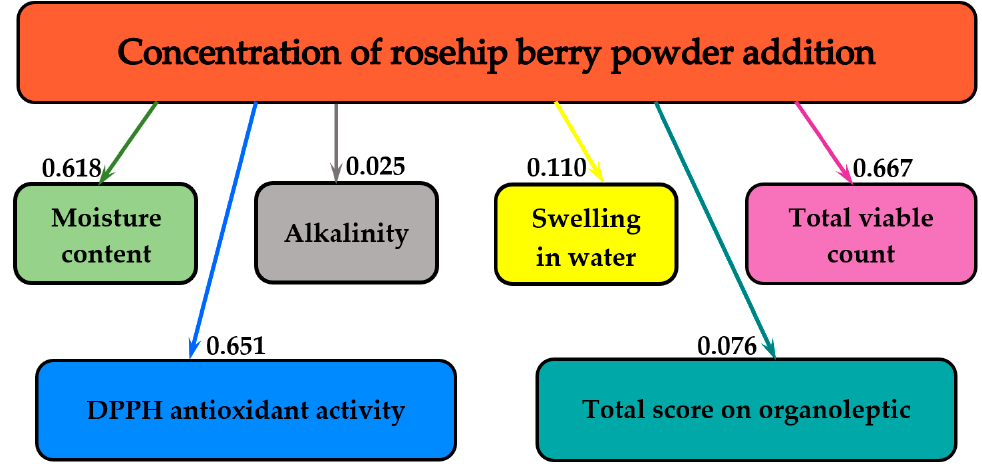
Figure 5. The influences of various quantities of rose hip powder on gingerbread physicochemical and organoleptic parameters, DPPH antioxidant activity and total viable count.